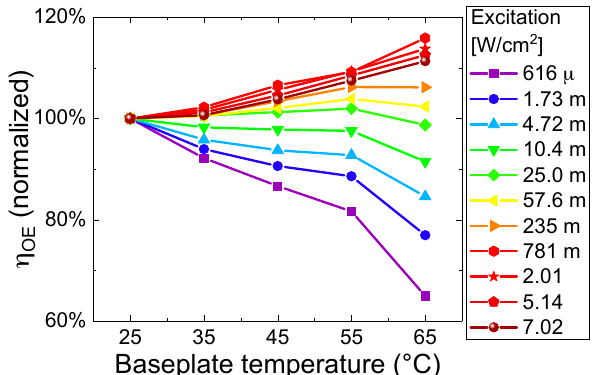
Figure 7. Optical-to-electrical power conversion efficiency, normalized to the value at 25 °C, as a function of temperature for various excitation densities.